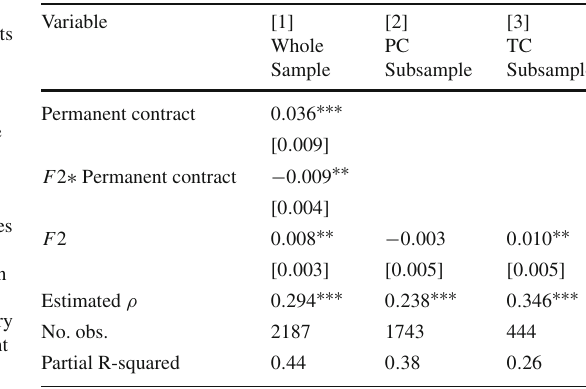
Table 10 Random effects training probit—marginal effects The dependent variable is training incidence